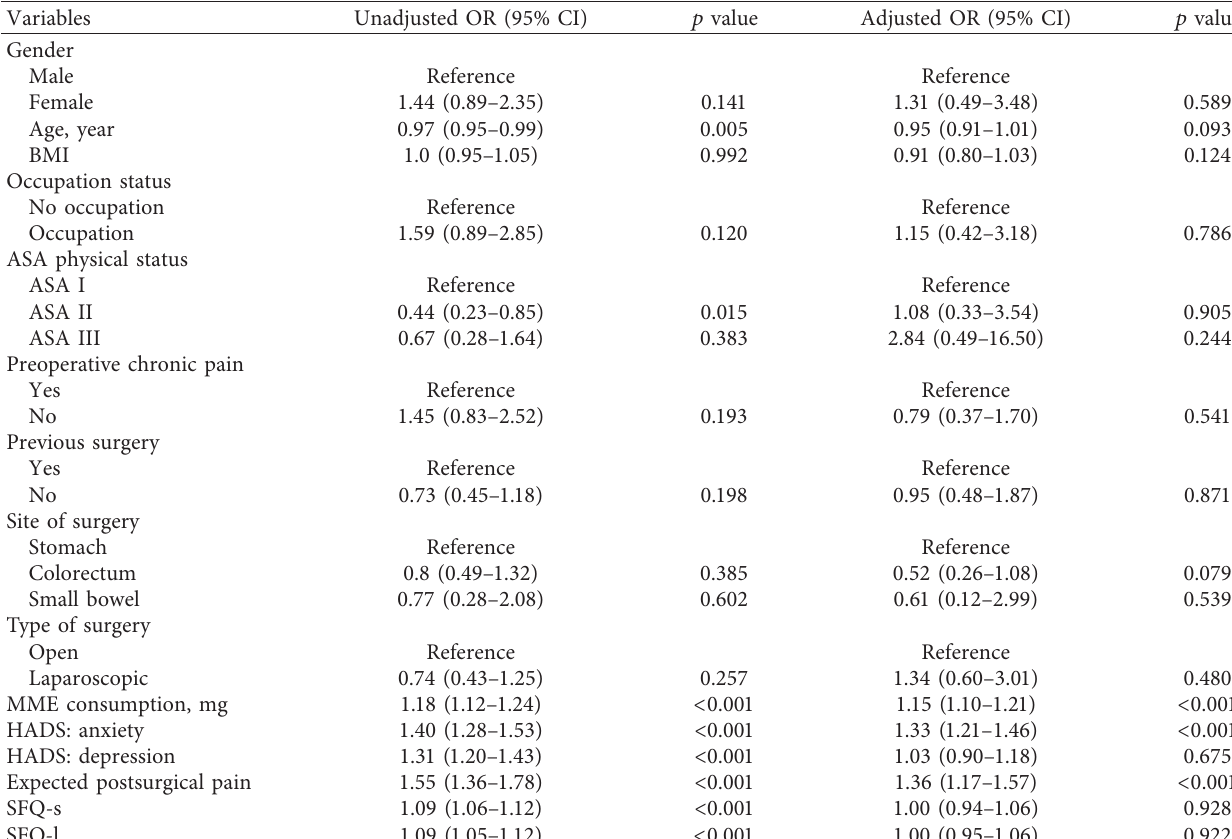
Table 5: Univariate and multivariate analyses of predictors for APSP